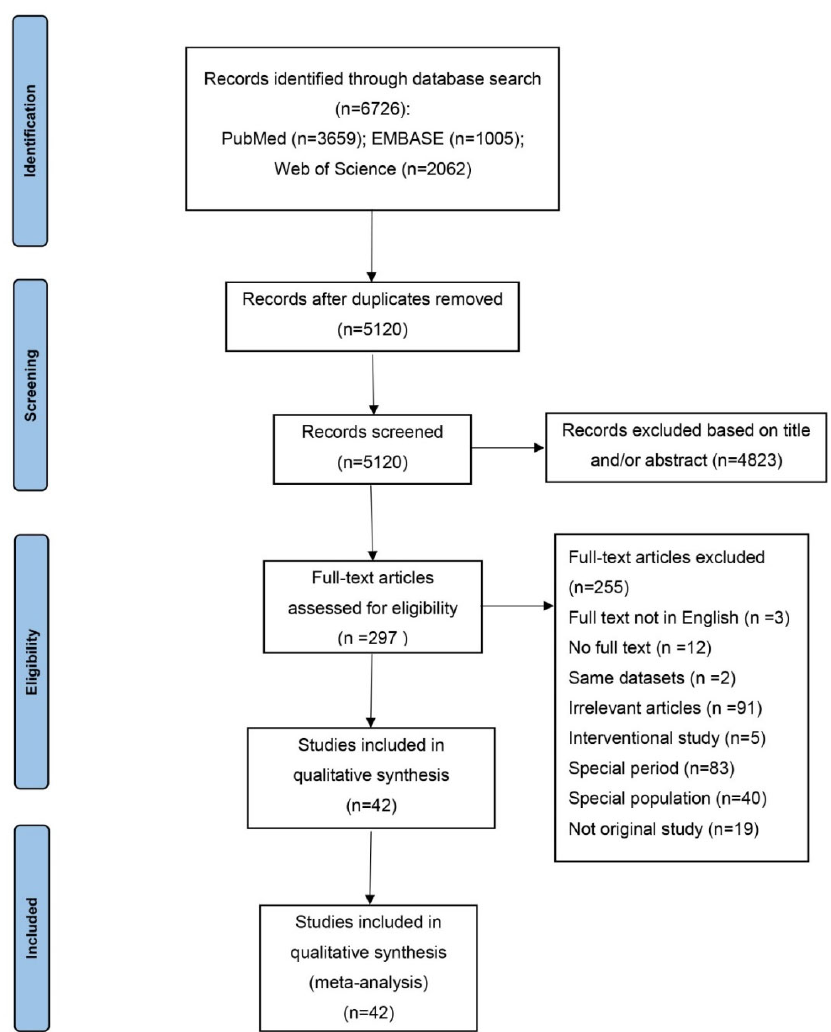
Figure 1. Flowchart of study selection.